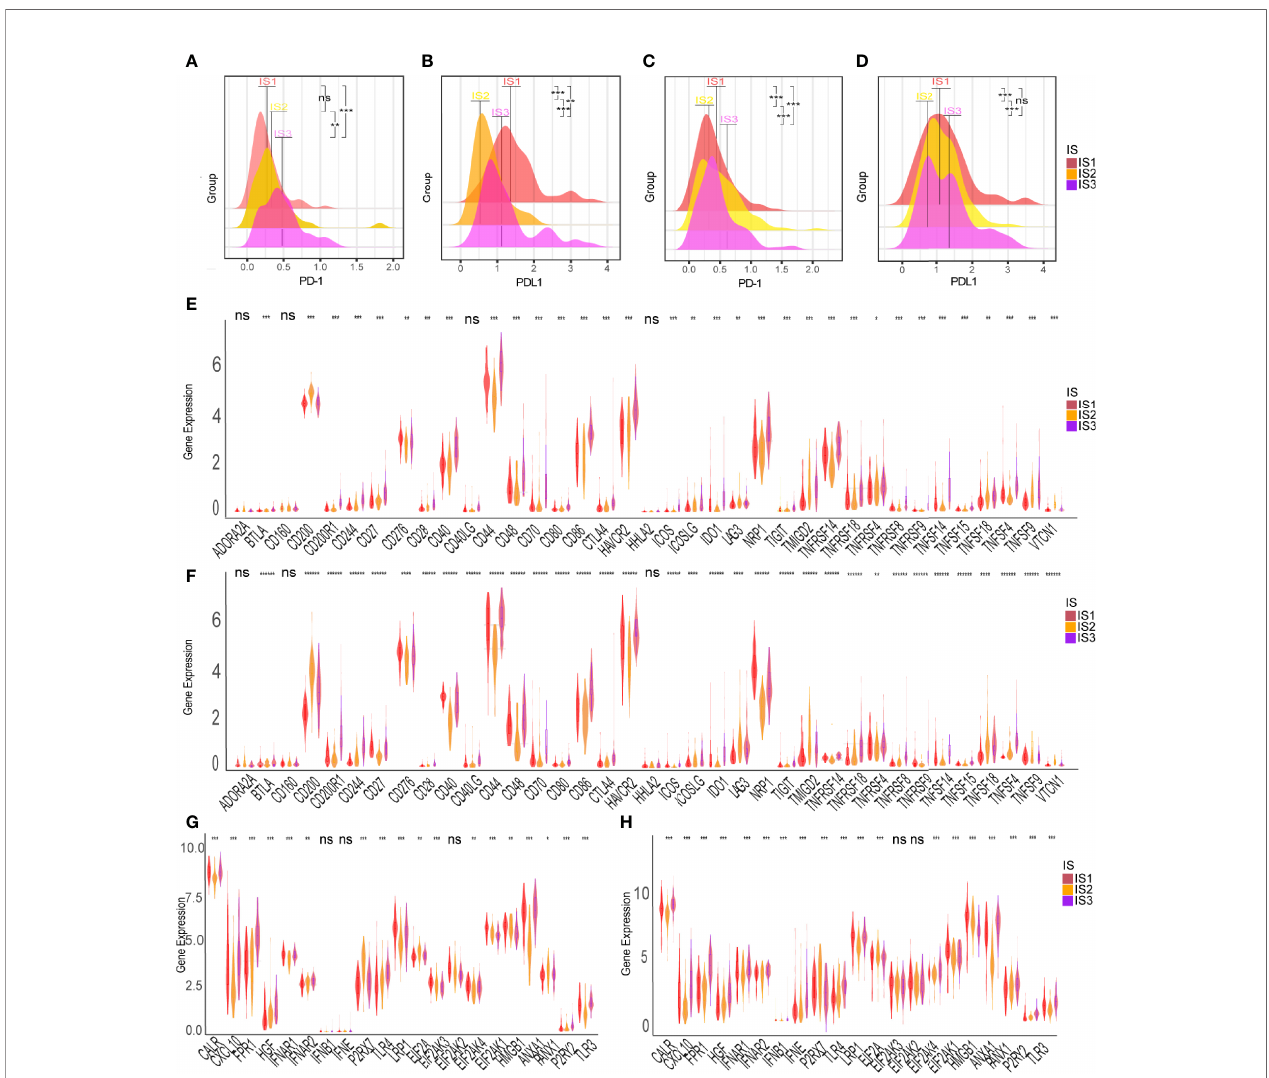
FIGURE 6 | Association between immune subtypes and ICPs and ICD modulators. Differential expression of PD-1 among the GBM immune subtypes in (A) TCGA and (C) CGGA cohorts. Differential expression of PD-L1 among the GBM immune subtypes in (B) TCGA and (D) CGGA cohorts. Differential expression of ICP genes among the GBM immune subtypes in (E) TCGA and (F) CGGA cohorts. Differential expression of ICD modulator genes among the GBM immune subtypes in (G) TCGA and (H) CGGA cohorts. * p < 0.05, ** p < 0.01, *** p < 0.001, **** p <0.0001, ****** p <0.000001. ns, no signi fi